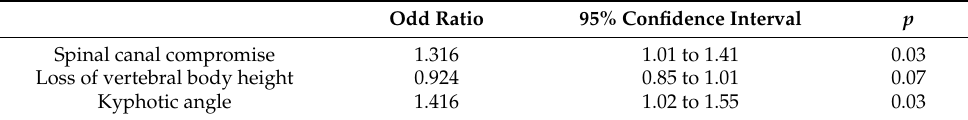
Table 6. Multiple logistic regression analysis of nonoperative treatment